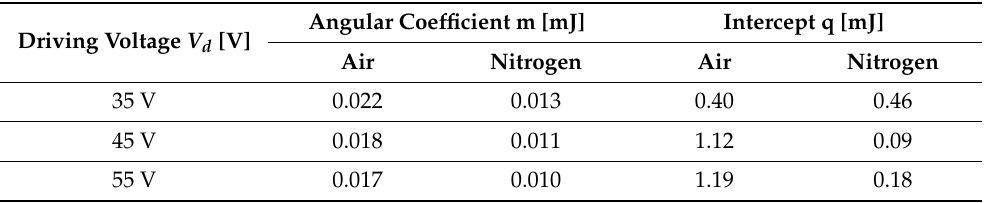
Table 3. Angular coefficients and intercept values corresponding to the linear fits of 𝑬 𝒓 (cid:3364)(cid:3364)(cid:3364) versus I Lg in air and nitrogen.